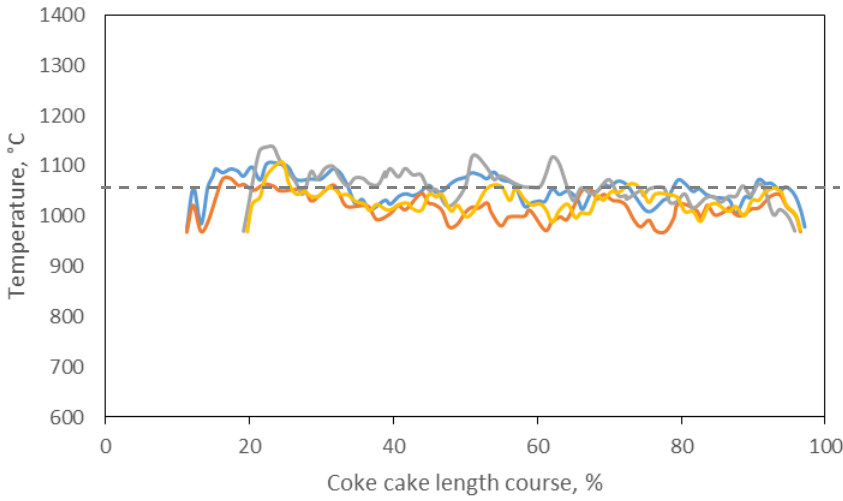
Figure 4. Temperature distributions along the discharged coke, defined with a thermographic camera on PWR-63 batteries.